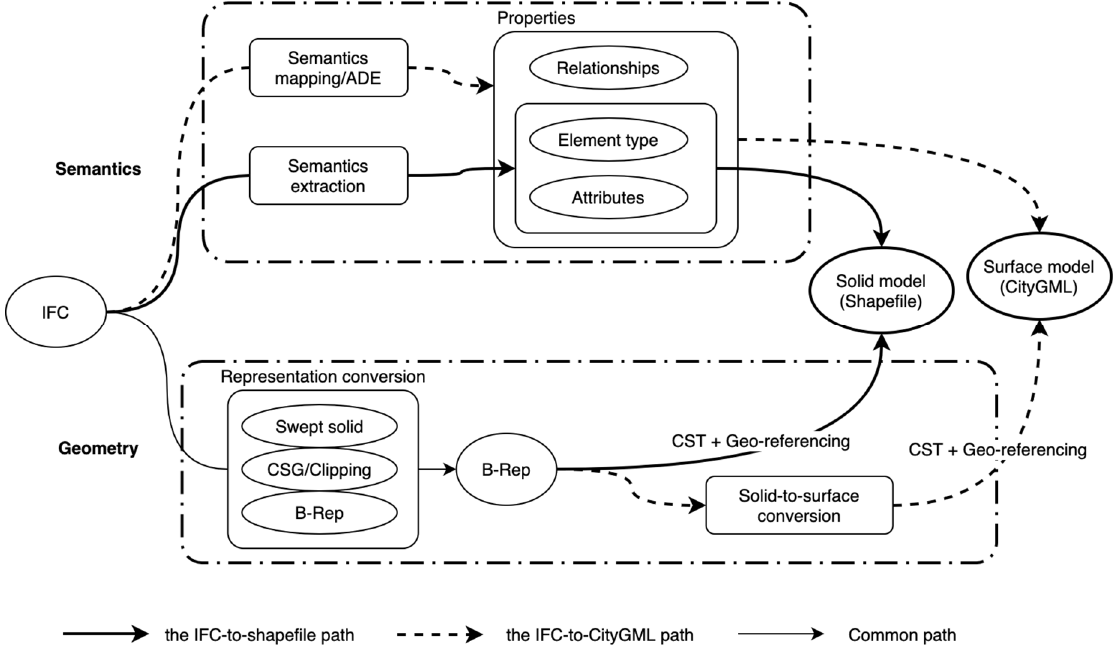
Figure 17. Paths for BIM-to-GIS data conversion .